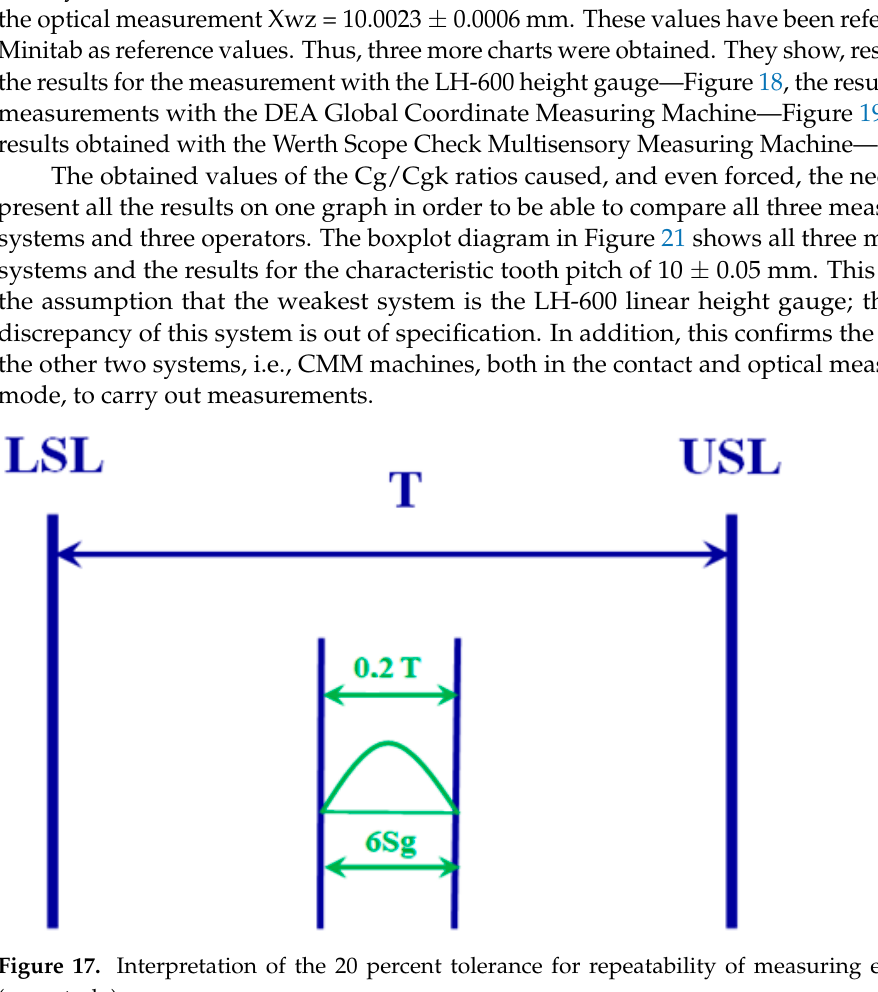
Figure 18. Tooth spacing 10 ± 0.05 mm—Cg/Cgk indicators for the LH-600 height gauge (own study).